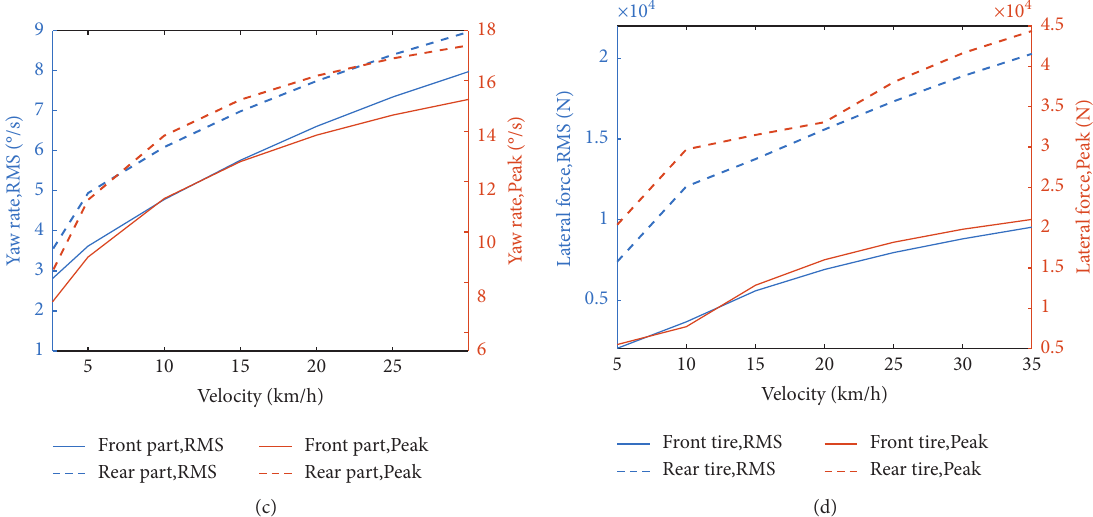
Figure 15: Vehicle performance of the vehicle speed variation. (a) RMS and peak value of tire sideslip angle. (b) RMS and peak value of vehicle sideslip angle. (c) RMS and peak vehicle yaw rate. (d) RMS and peak value of lateral